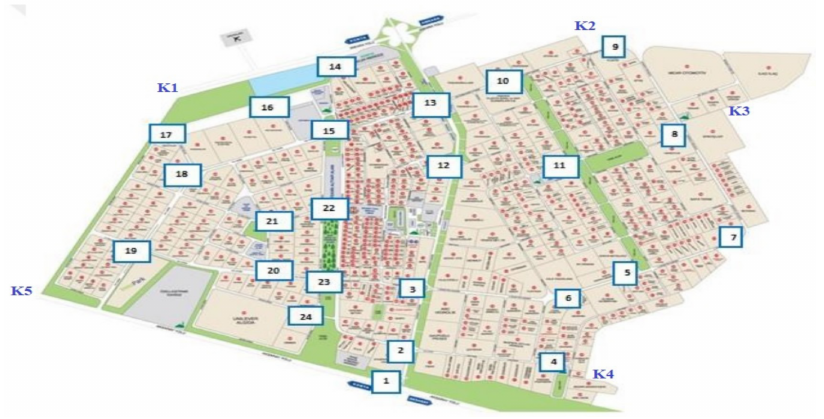
Figure 11. Points exceeding the PM 10 limit value in Konya Organized Industrial Zone.